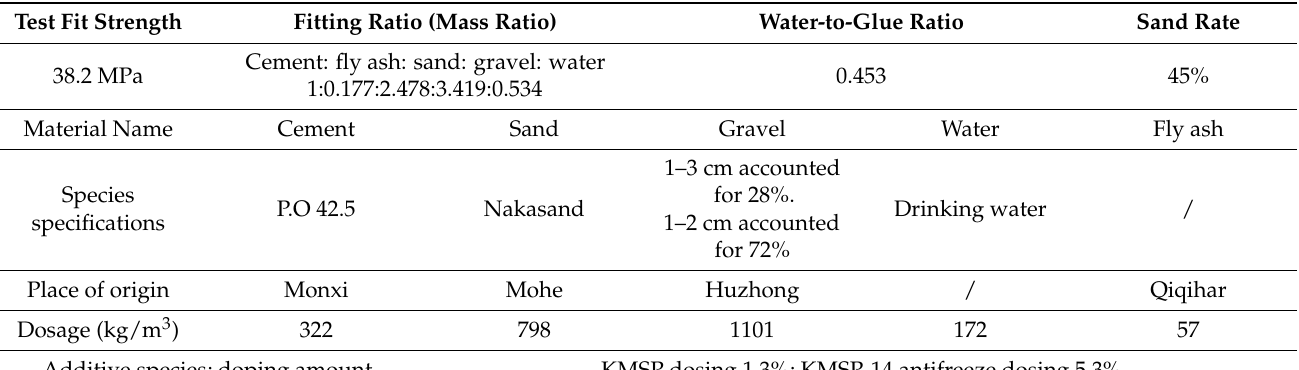
Table 4. Low heat of hydration C30 concrete